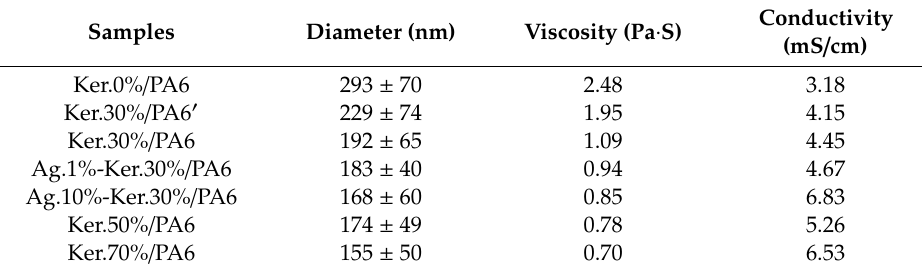
Figure 2. SEM images of fibrous membranes with different concentrations of polymer mats: ( a ) Ker.0%/PA6, ( b ) Ker.30%/PA6 ′ , ( c ) Ker.30%/PA6, ( d ) Ag.1%-Ker.30%/PA6, ( e ) Ag.10%-Ker.30/PA6, ( f ) Ker.50%/PA6, and ( g ) Ker.70%/PA6. The histograms show the distribution of fiber diameters corresponding to their SEM image. ( h ) TEM images, ( i ) HAADF-STEM (high-angle annular dark field-scanning transmission electron microscopy), and the corresponding EDS (energy dispersive spectrometer) mapping of the Ag, S, and N elements in composite nanofibers. Table 1. Composite solution and nanofiber performance.